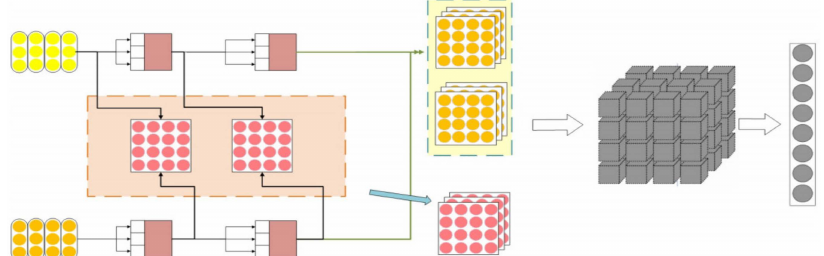
Figure 3. Improved DAM with shifted granularity matching method, the output of the representation part (representation of utterance and response in different granularities) is matched and calculated by shift mode to obtain a new matrix (represented in red), which is arranged and aggregated into a 3D matrix (grey) with the other two